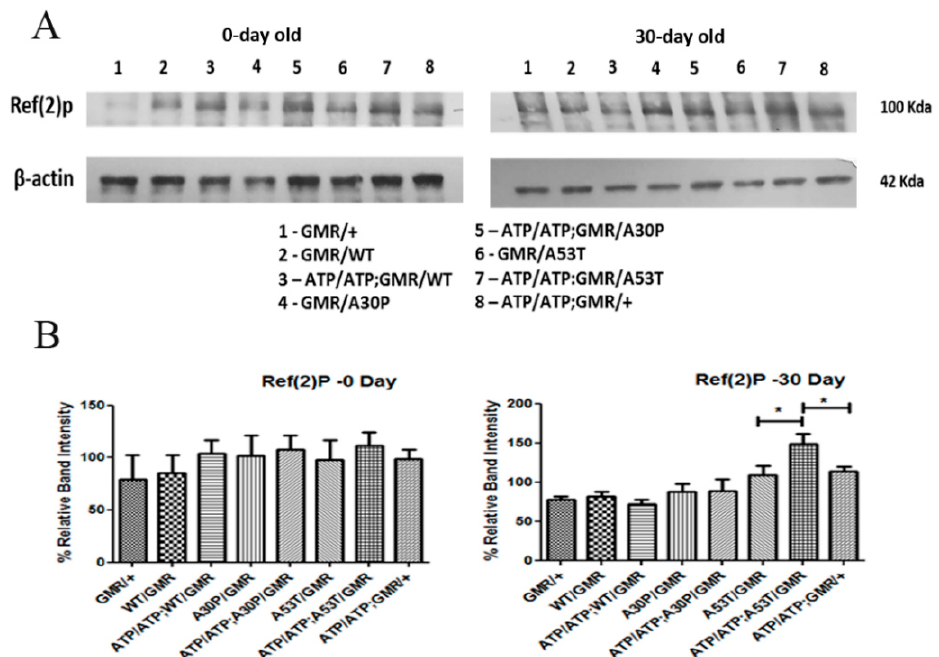
Figure 5. ATP13A2 silencing causes autophagy change in autophagic marker (p62) of mutant α -syn A53T. Expression of Ref(2)P, the Drosophila homologue of p62 in 0- and 30-day-old fly ( A ). Immunoblots showing an increase in Ref(2)P in ATP13A2-silenced flies expressing A53T compared to A53T alone, suggests inhibition of autophagy when ATP13A2 is silenced ( A ). Corresponding densitometric graphs (0- and 30-day-old fly) where ATP13A2 RNAi flies expressing WT, A30P and A53T α -syn is normalized to 100% of respective controls (GMR with α -syn) is shown ( B ). Graph represents mean ± S.E.M. for 3 independent experiments. Differences in means were compared by one-way ANOVA followed by the Newman–Keuls Multiple Comparison post hoc test. * p < 0.05.